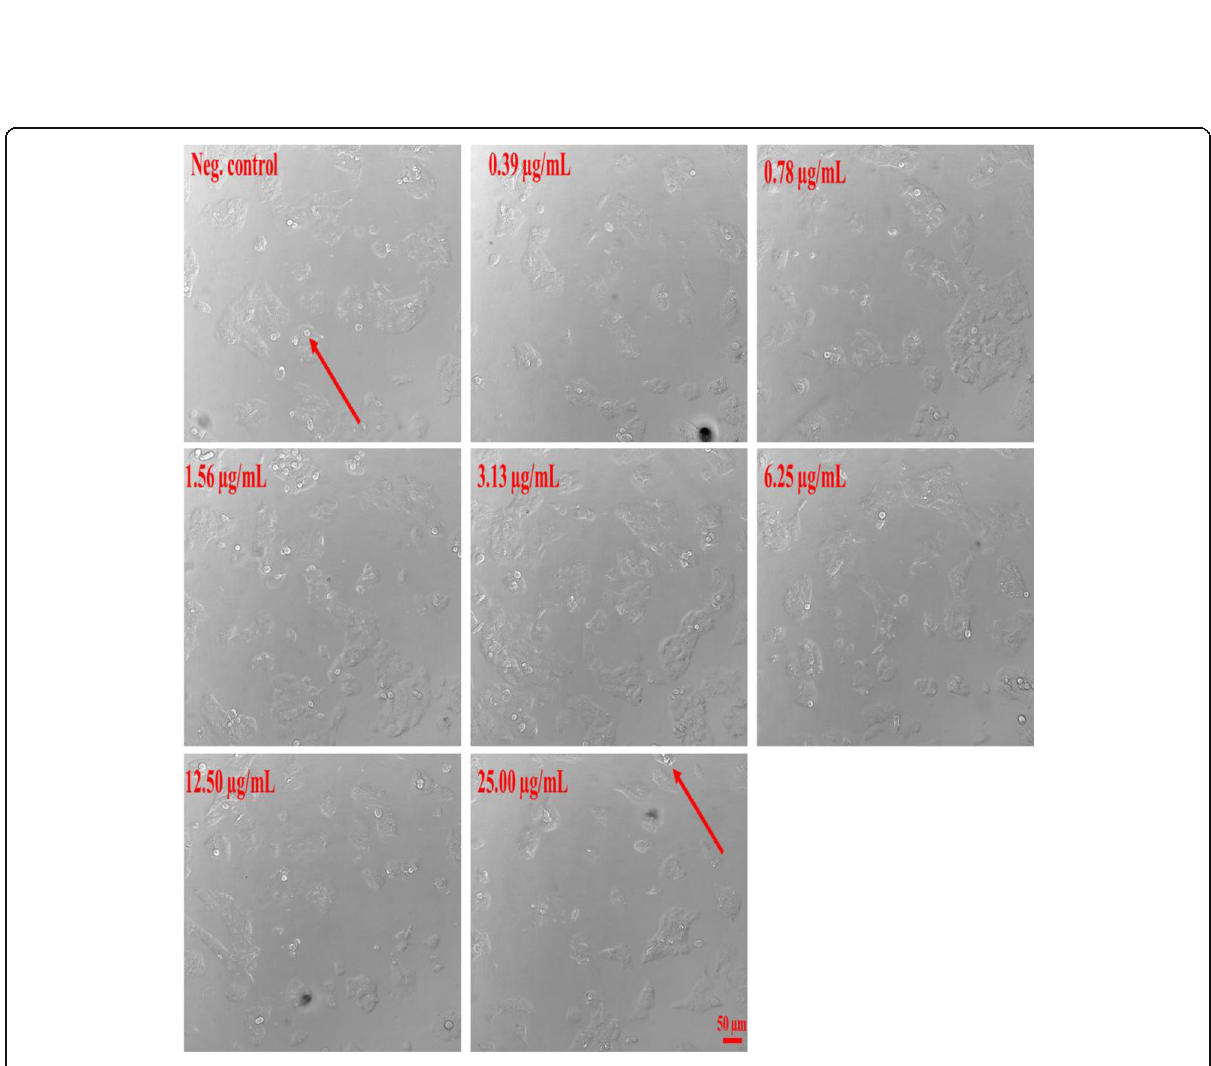
Fig. 10 Changes in cellular morphology as recorded using a widefield fluorescent microscopy. Resveratrol-induced morphological changes in HepG2 cells after 24 h of treatment